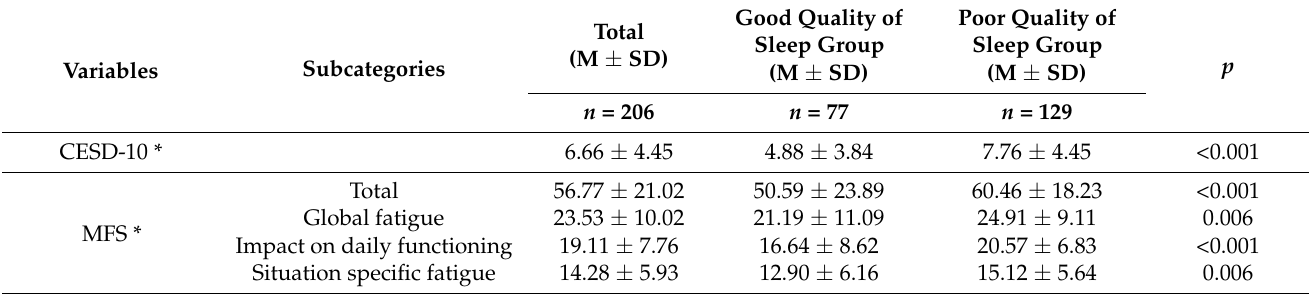
Table 3. Differences of physical and mental health related characteristics between the two sleep quality groups ( N =